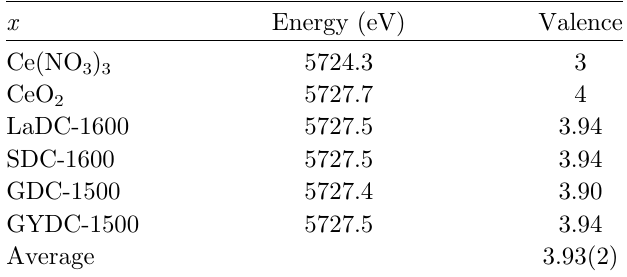
Table 5. Ce(NO ) , CeO and LaDC, SDC, GDC, and 3 3 2 GYDC sample powders with 1500 – 1600 (cid:1) C treatment: Ce L -edge XANES spectrum single maximum differential energy shoulders and corresponding Ce